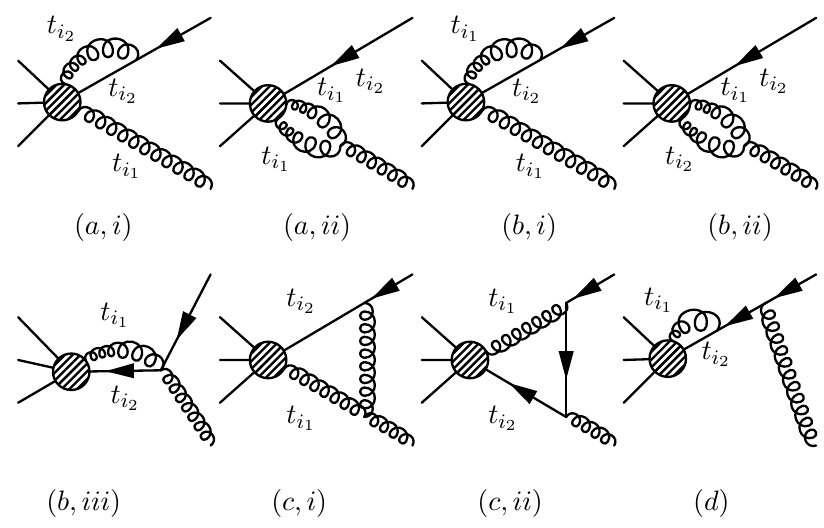
Figure 10 . Diagrams contributing to the mixing of B -type currents into B -type currents in the collinear sector with fermion number F i =